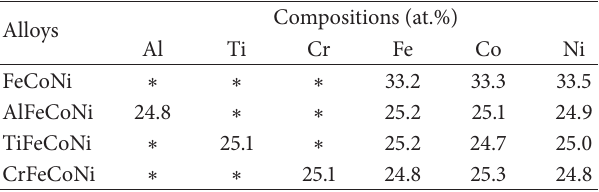
Table 1: The chemical compositions of the (Al, Cr, Ti)FeCoNi targets.